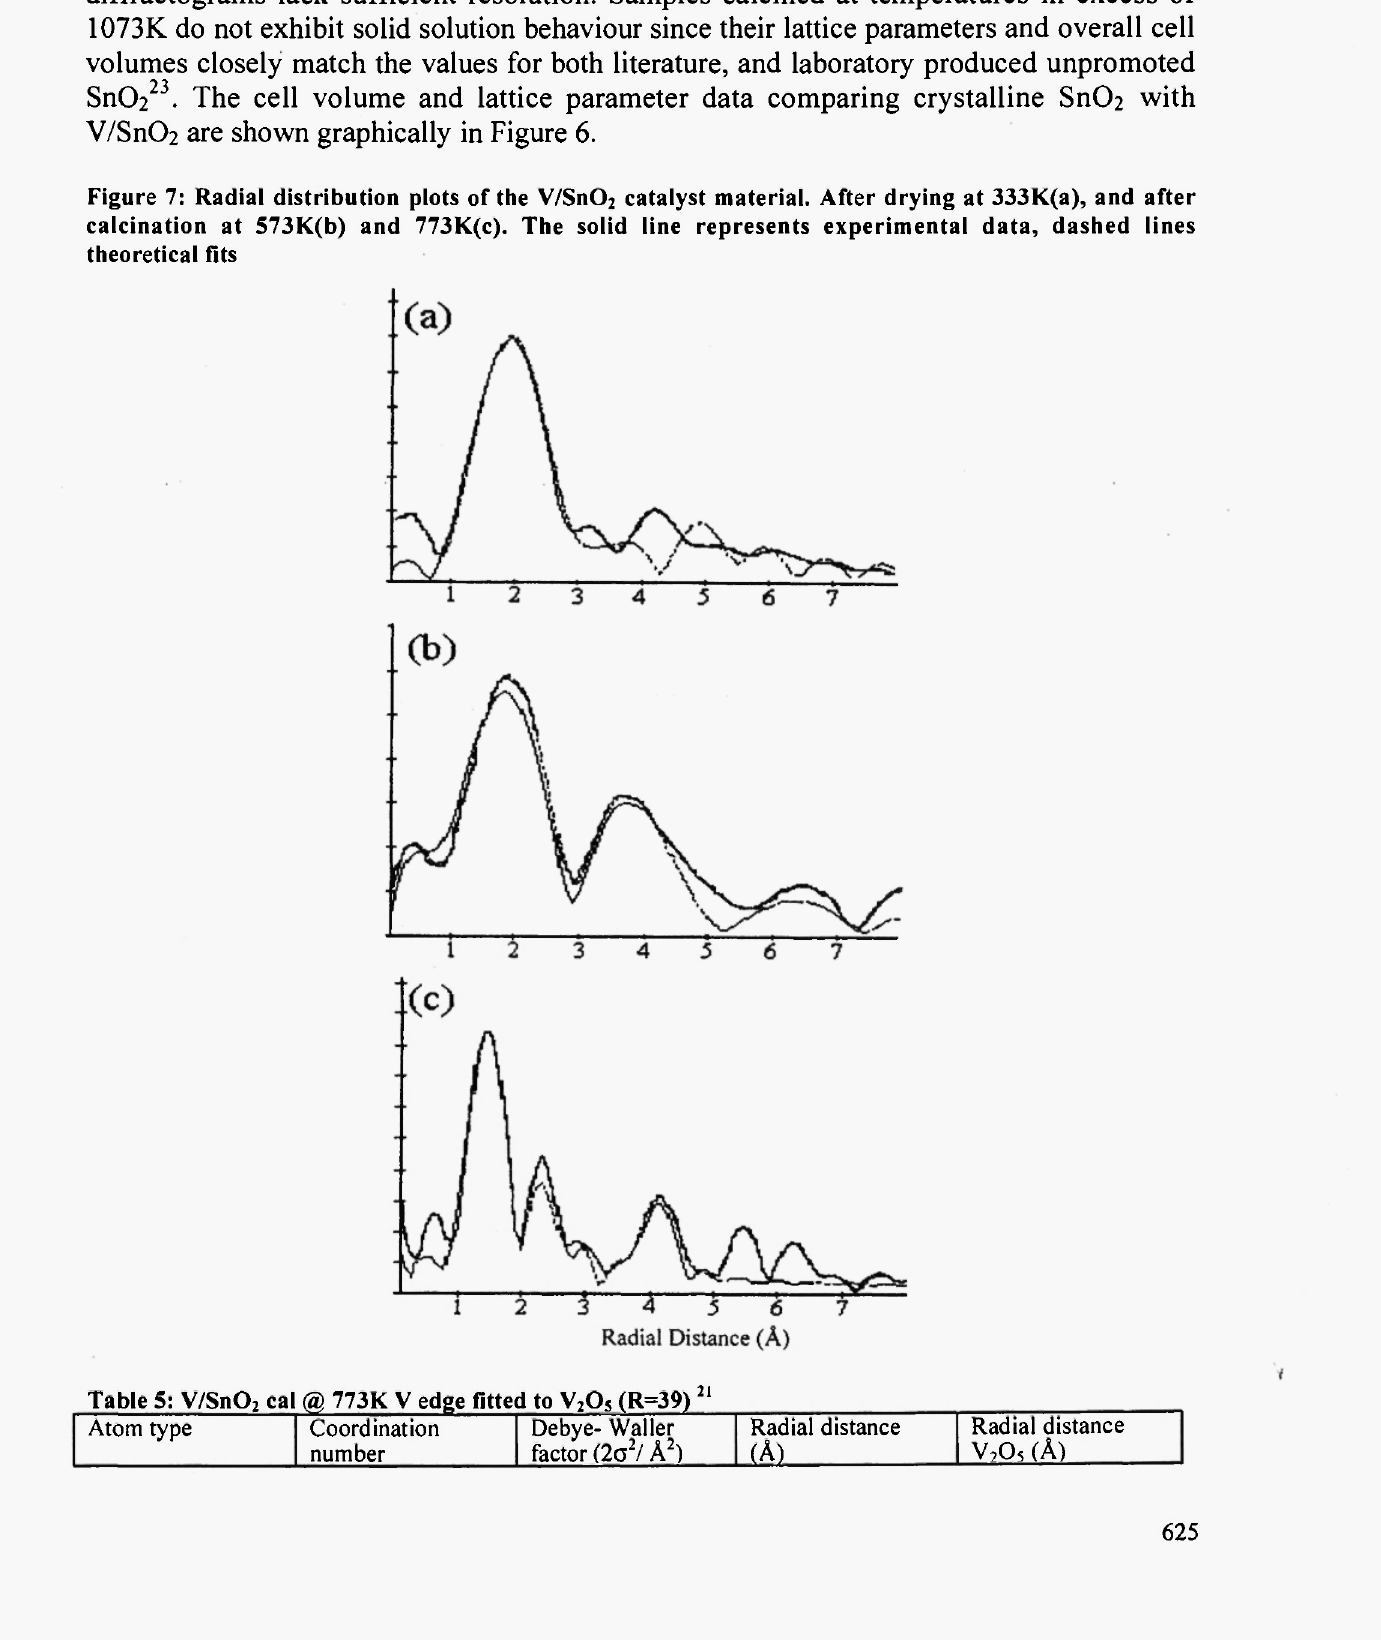
Figure 7: Radial distribution plots of the V/Sn0 2 catalyst material. After drying at 333K(a), and after calcination at 573K(b) and 773K(c). The solid line represents experimental data, dashed lines theoretical